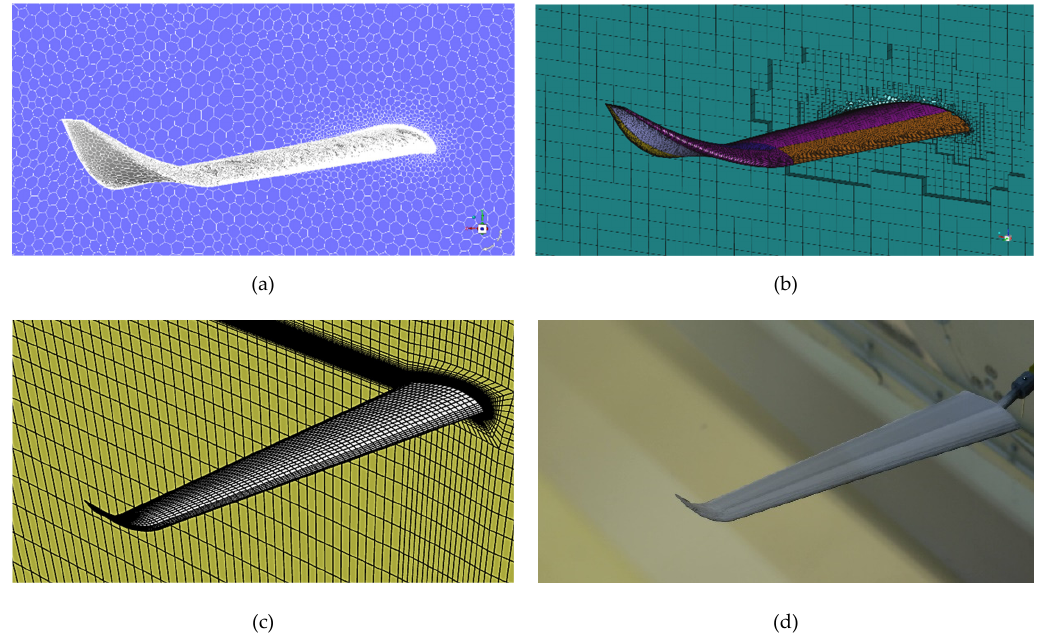
Figure 5. Domain of a 3-dimension Grid ( a ) Unstructured mesh—Fluent ( b ) Mosaic Poly-hexcore mesh—Fluent ( c ) Structured mesh—Fluent ( d ) Wing settled on Three Components Balance of subsonic Wind Tunnel.